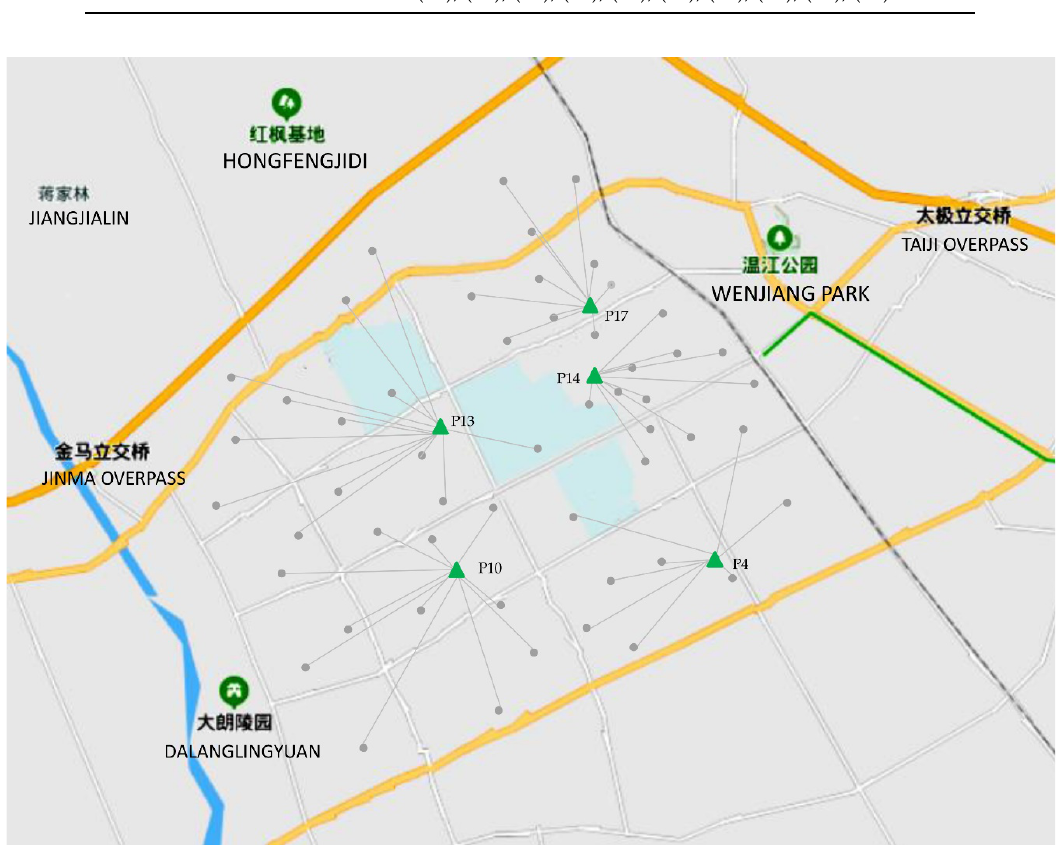
Figure 4. The locations of charging stations and their service areas.